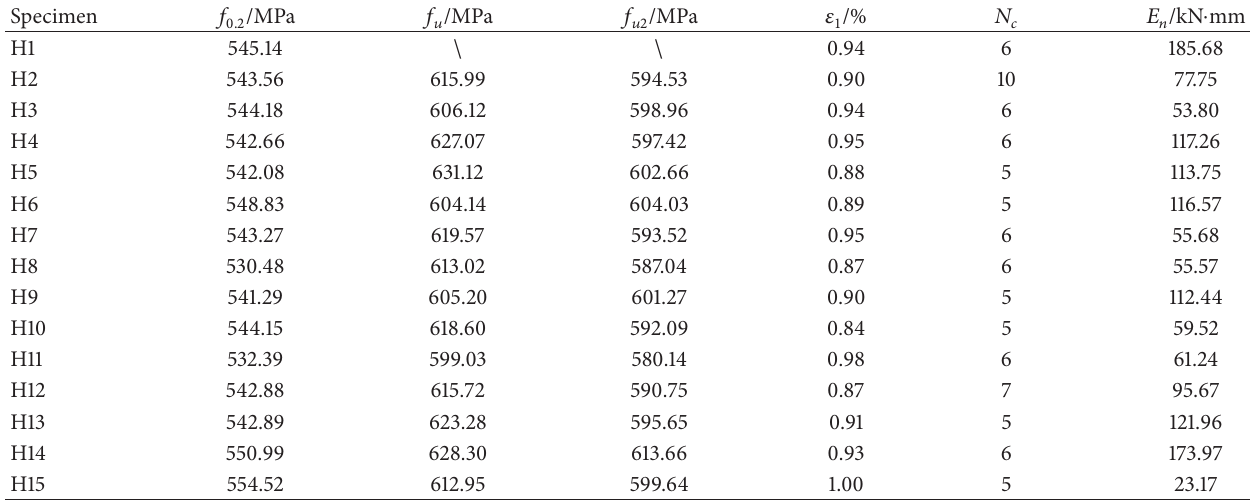
Table 3: Test results of cyclic loading.